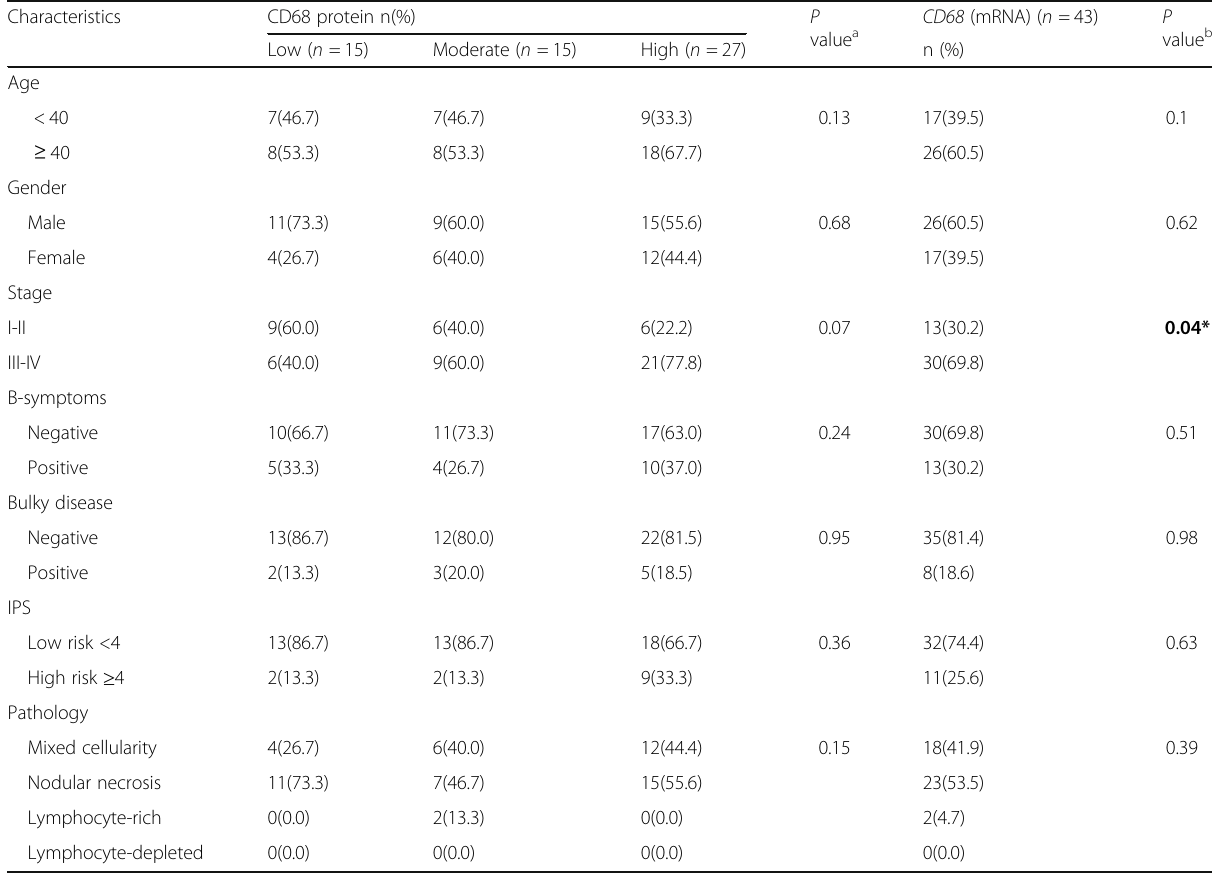
Table 2 Correlation between CD68 (IHC and mRNA) expression and clinic-pathological features of the patients